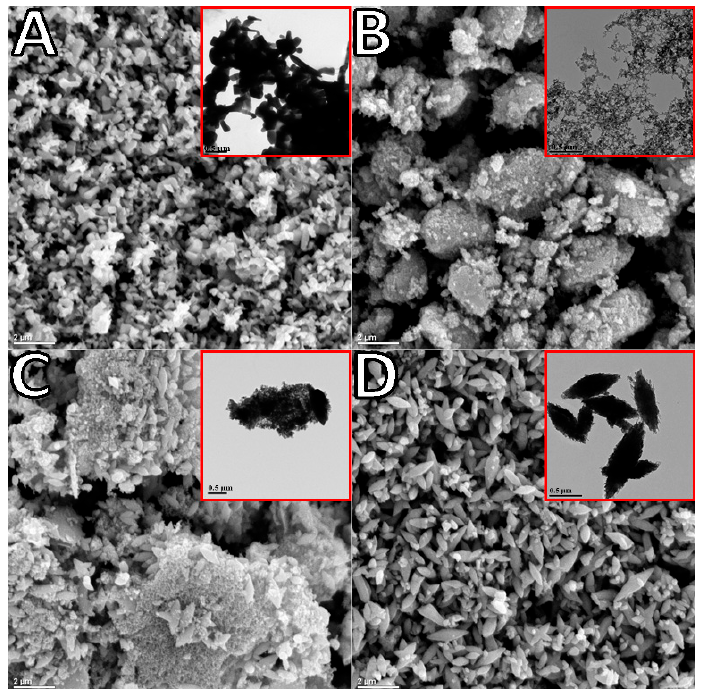
Figure 2. SEM of ZnO annealed (300 °C, 10 min) and TEM (inserts) of the commercial ZnO ( A ), ZnO filtrated after 2 h of synthesis, 2H filtrated ( B ), ZnO filtrated after 3 h of synthesis, 3H filtrated ( C ) and ZnO collected from aqueous suspension after water was evaporated, 3H evaporated ( D ), synthesized by the bipolar electrochemical reaction.